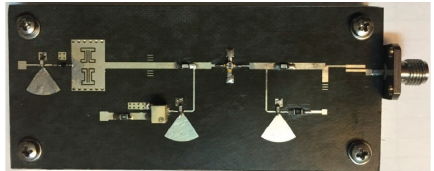
Figure 21: The circuit layout of the fabricated oscillator.